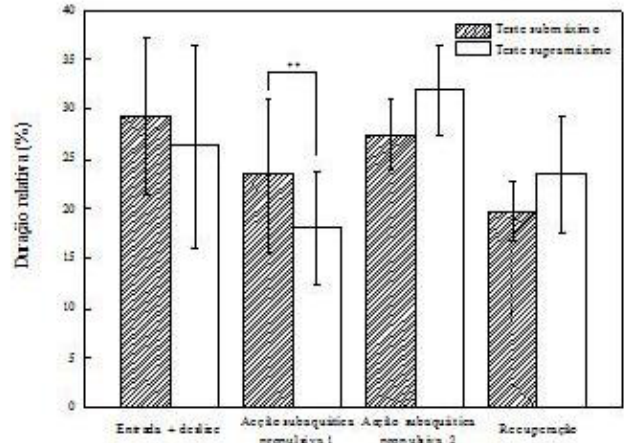
Figura 4. Média de desvio padrão da duração relativa de cada uma das fases do ciclo gestual nos testes submáximo e máximo (**p<0,01).